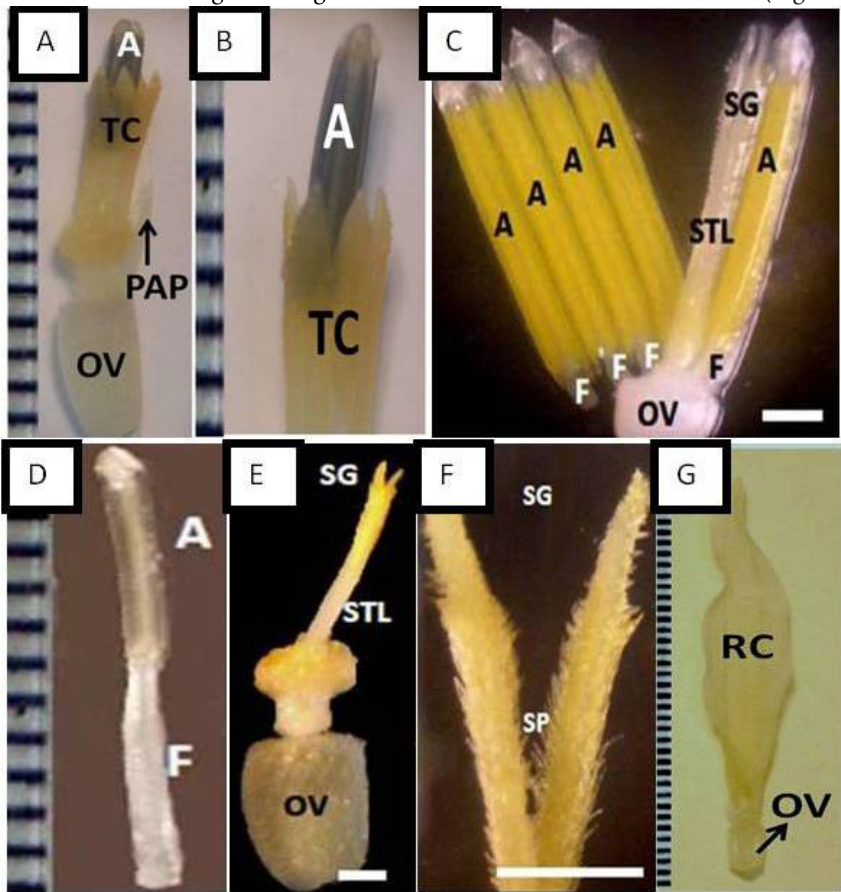
Fig. 1. Hermaphrodite (A-F) and pistillate (G) florets viewed by stereomicroscope in H. an- nuus . A. Pappus; B. Tubular corolla; C. Anther tube which removed under the stereomicro- scope and stamens with free filaments and fused anthers; D. Anther and filament; E. Stigma, style and inferior ovary; F. Stigmatic branches and stigmatic papillae; G. Ray corolla and inferior ovary with no ovule. A: Anther; F: Filament; PAP: Pappus; OV: Ovary; RC: Ray corolla; SG: Stigma; SP: Stigmatic papillae; STL: Style; TC: Tubular corolla. Bar: